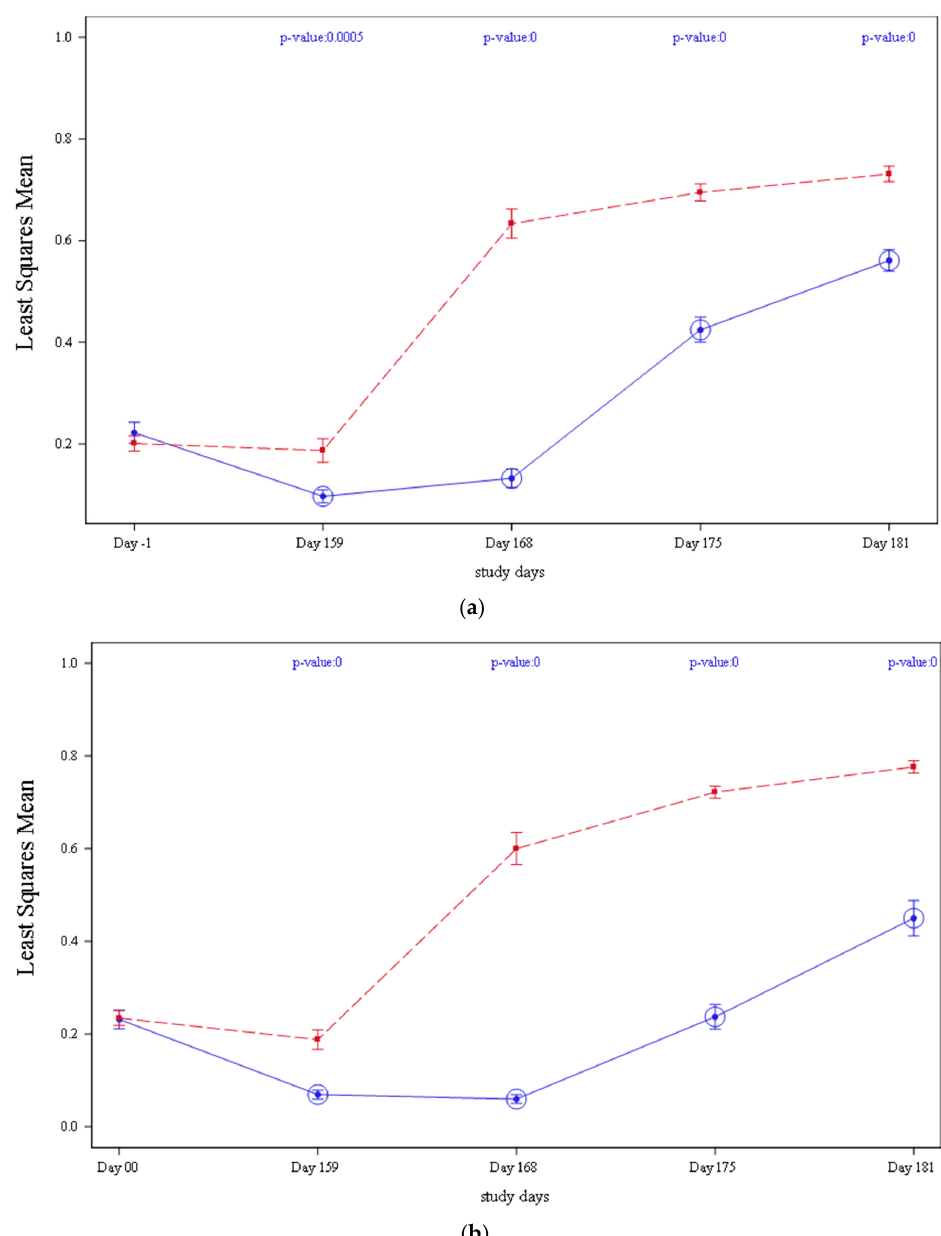
Figure 3. PCV2 serology (Least Squares Mean) by treatment and day of study and significance values: ( a ) PCV2 serology detected on study 1, results from T01 are represented in blue and results T02. are represented in red, when p -value < 0.0001 it was represented as 0; ( b ) PCV2 serology detected on study 2, results from T03 are represented in blue and results from